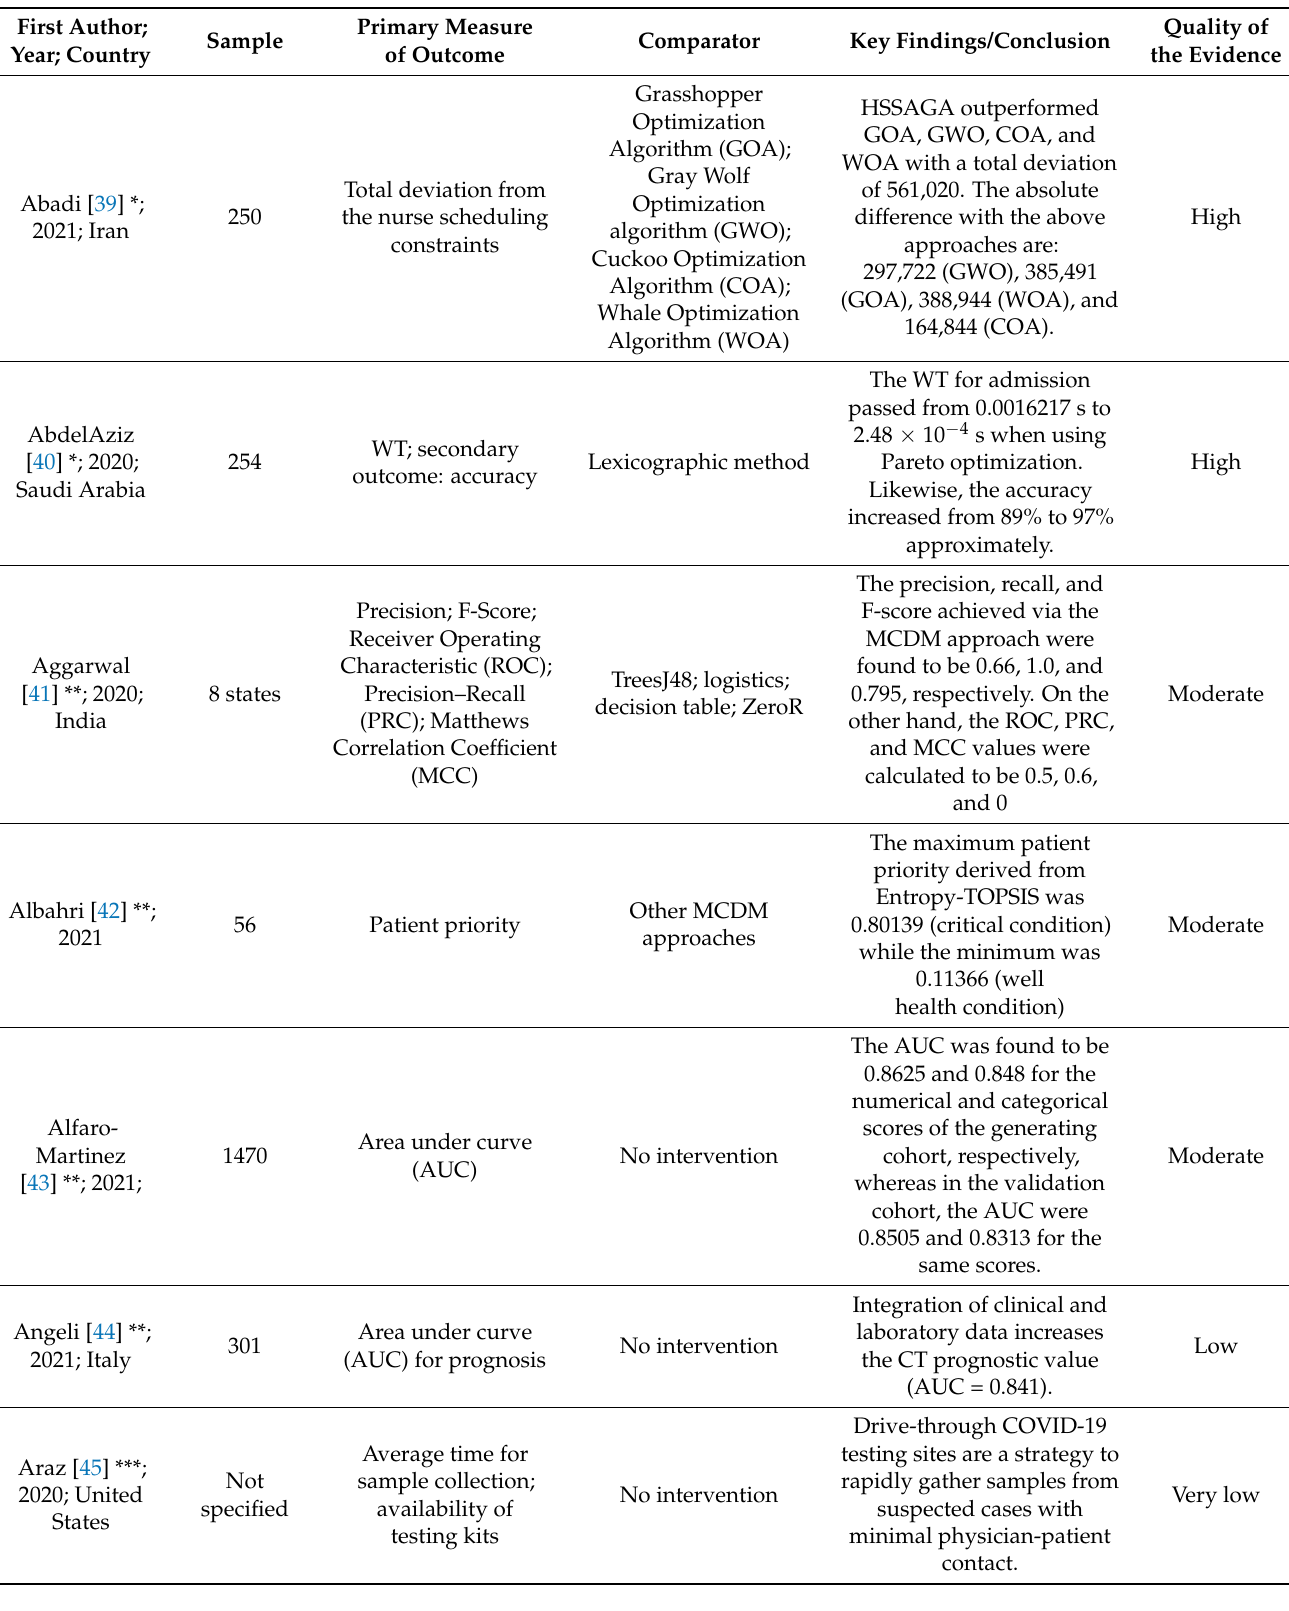
Table 1. Characteristics of the manuscripts selected for the